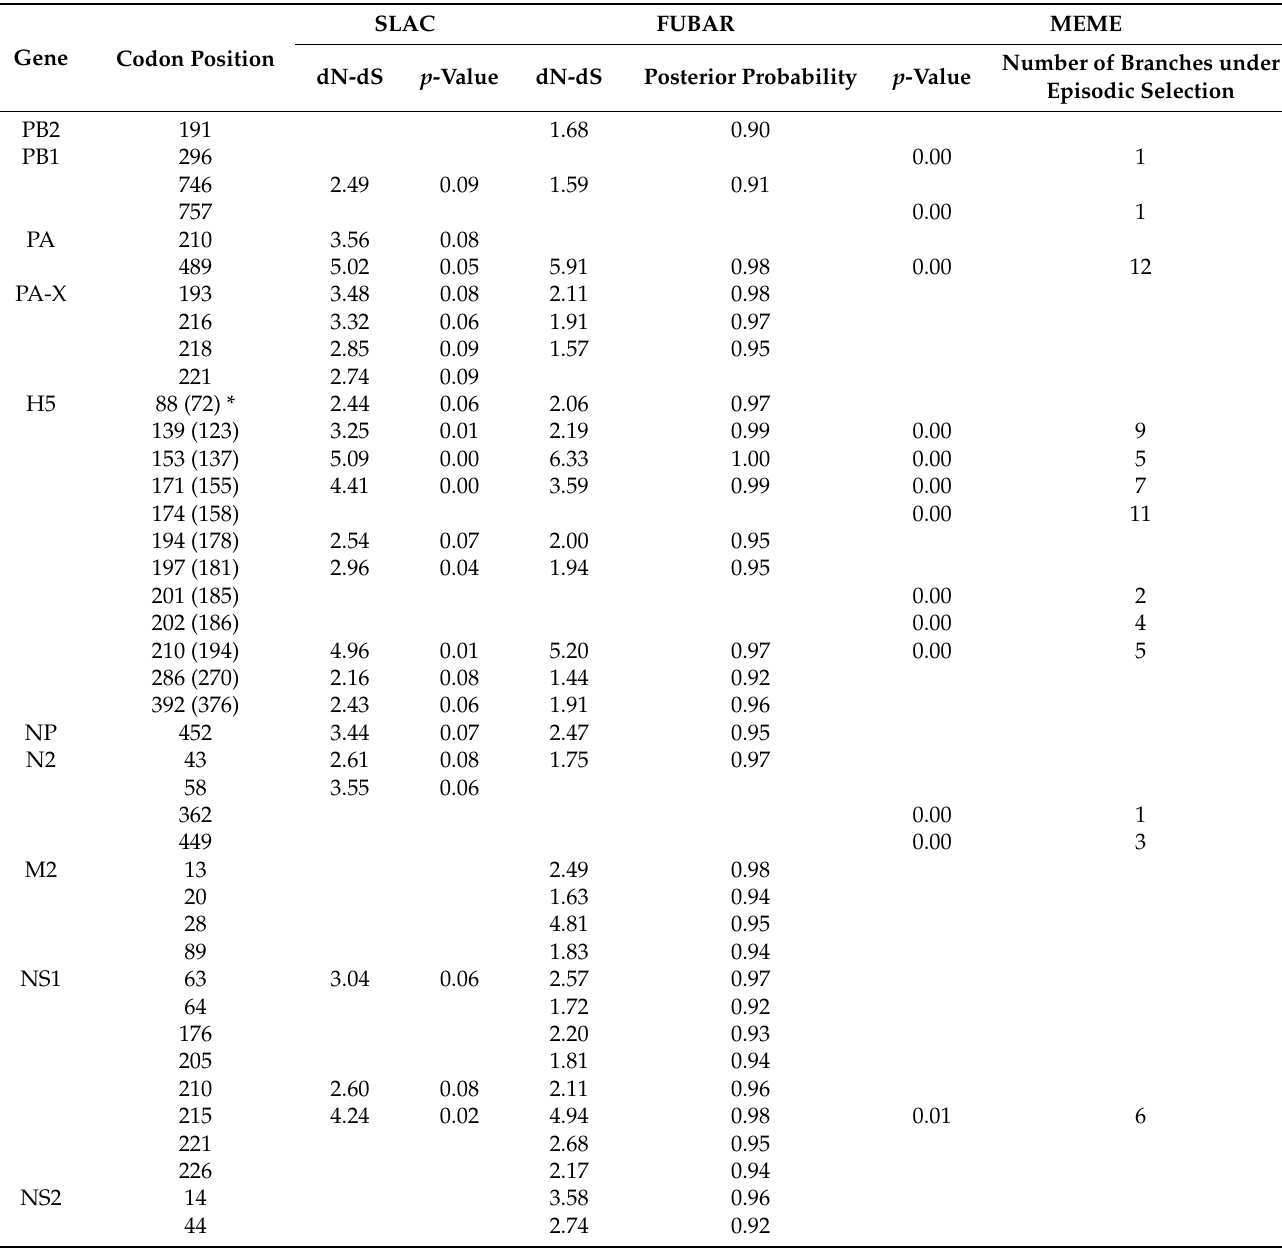
Table 2. Amino acid sites under putative positive selection detected using different analytical